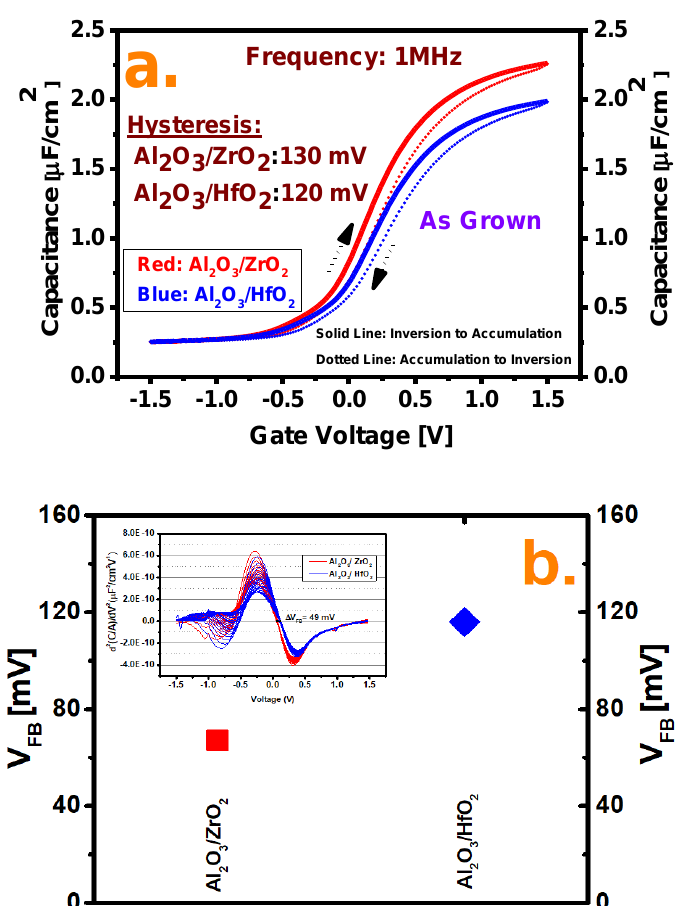
Figure 2. ( a ) Hysteresis comparison from − 1.5 V to + 1.5 V at 1 MHz for both cases. ( b ) Flat band voltage comparison for both films, as calculated by the inflection point method. Inset: Second derive of normalized C – V data for calculating the flat voltage shift.